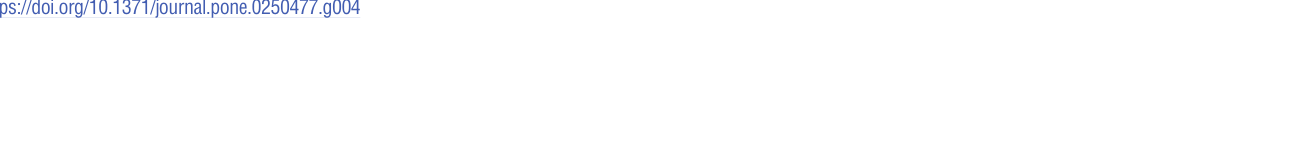
PLOS ONE | https://doi.org/10.1371/journal.pone.0250477 August 5,